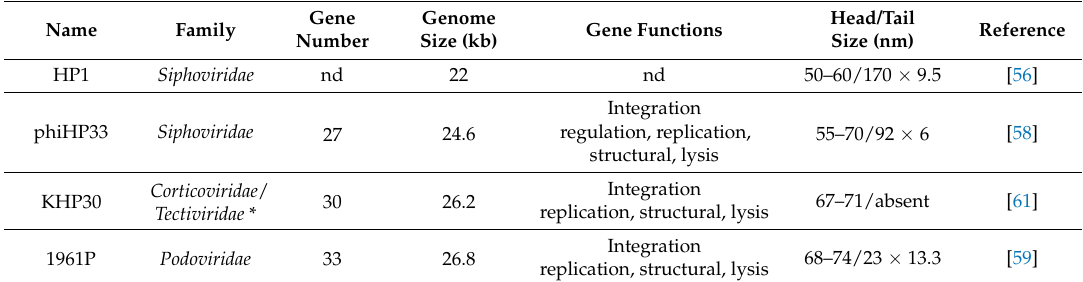
Table 1. Characteristics of H. pylori phages